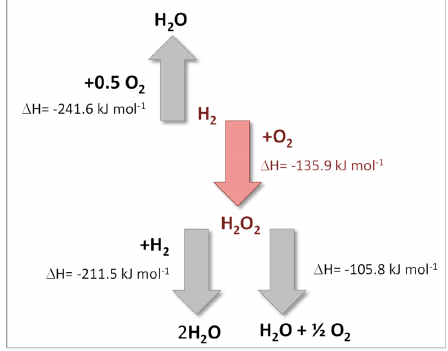
Figure 2. Reactions involved in the direct synthesis of H 2 O 2 . 63